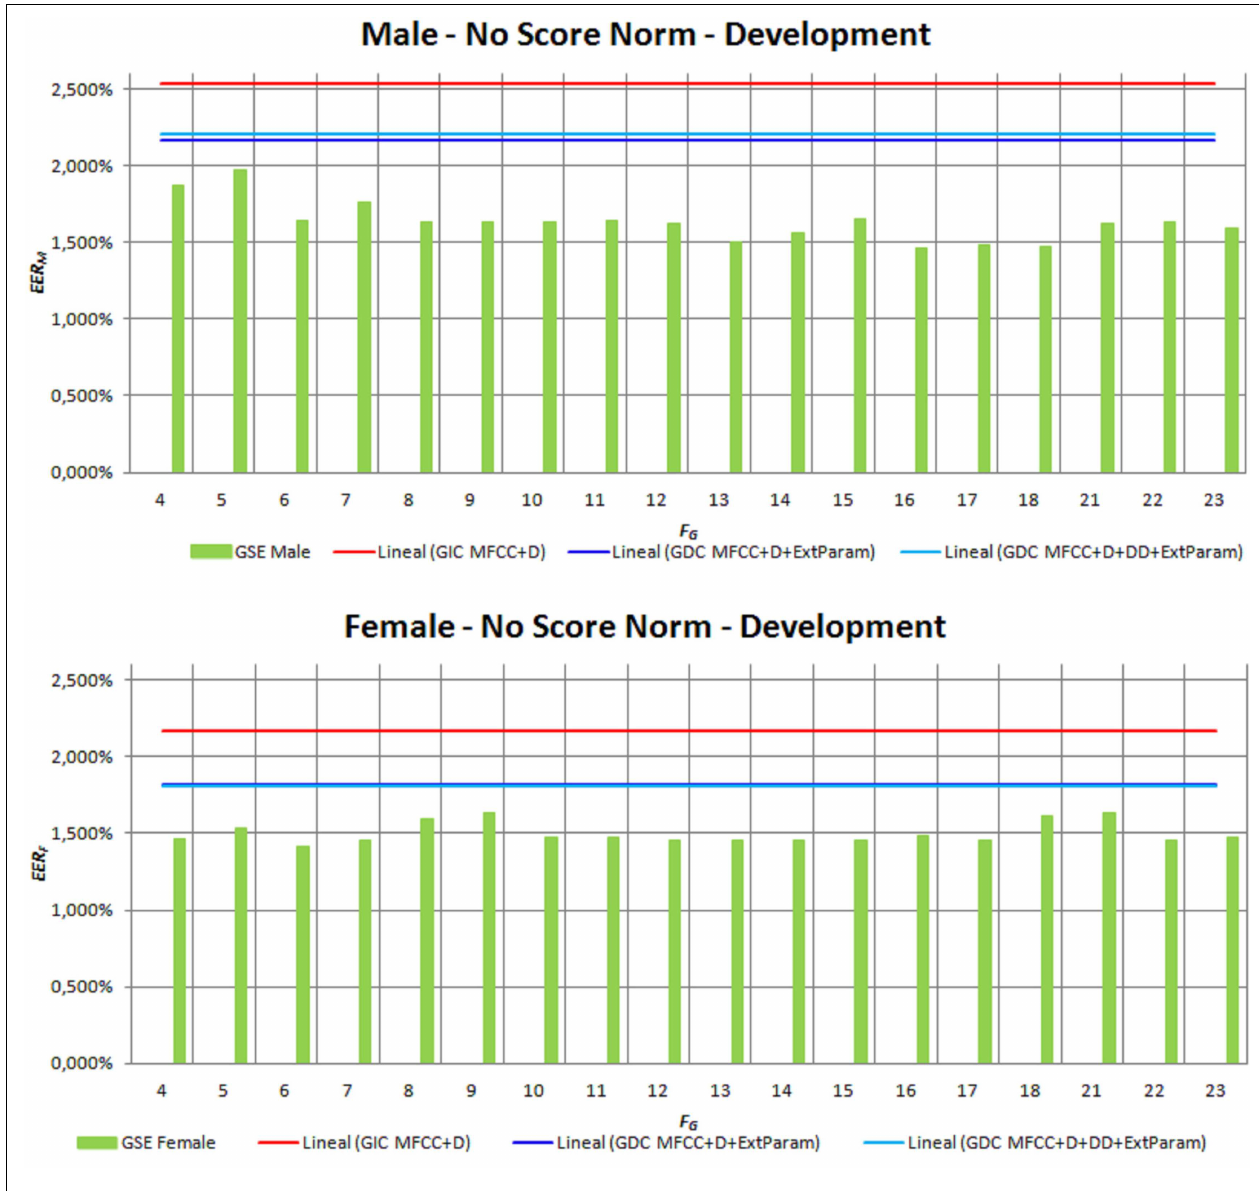
FIGURE 7 | Influence of the GSE configuration on the results achieved on terms of EER for both male and female speakers on development set